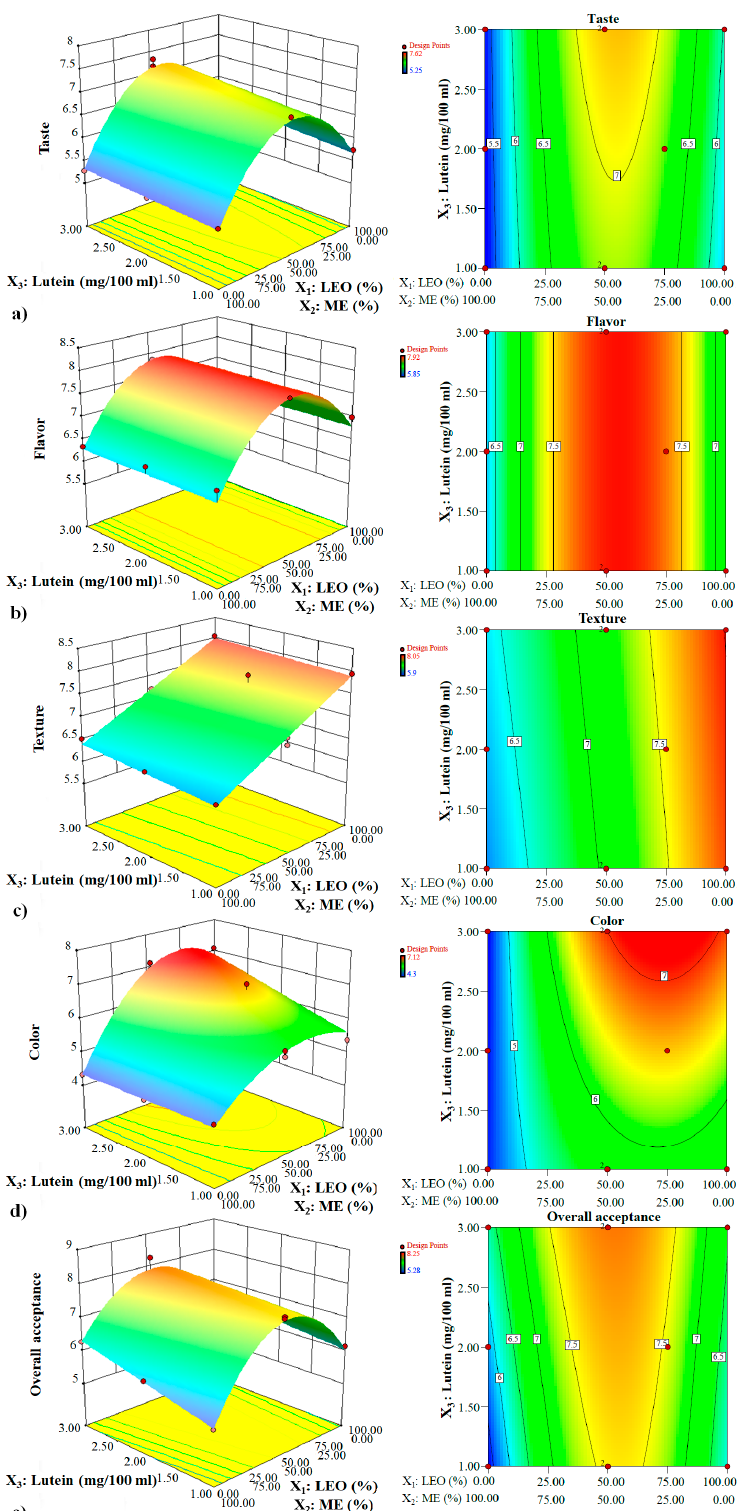
Figure 1. The change in ( a ) taste, ( b ) flavor, ( c ) texture, ( d ) color, and ( e ) overall acceptance based on different LEO and ME combinations under different lutein levels and in the absence of prebiotic fibers (in color) .